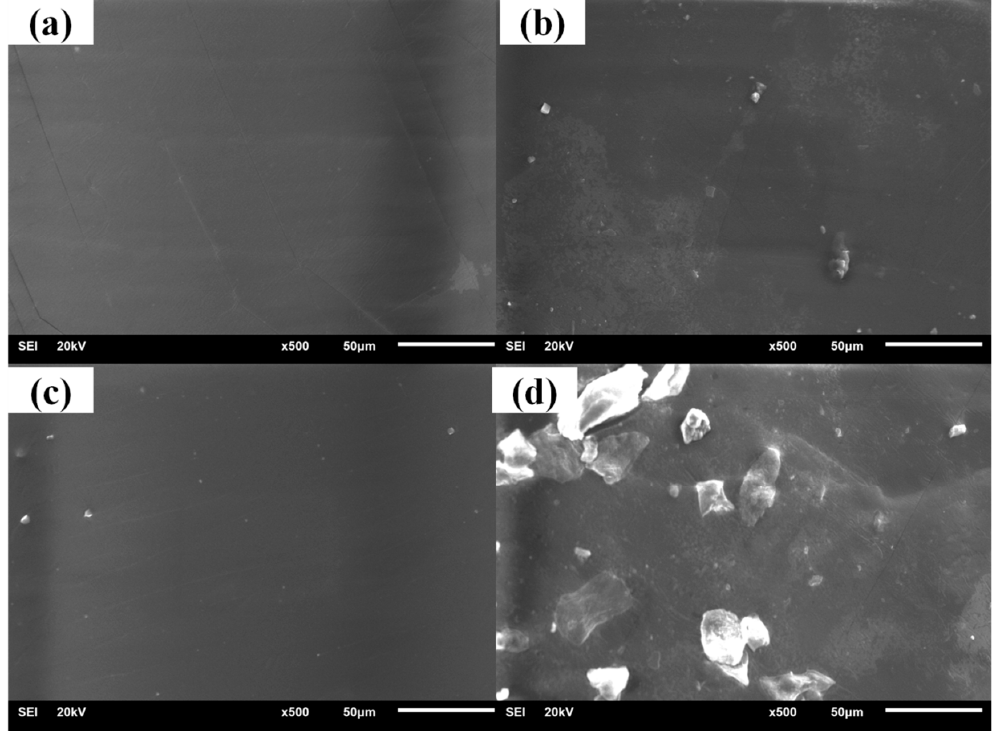
Figure 8. SEM patterns of XNBR/AO-60 before and after thermal aging: ( a ) XNBR/AO-60(20); ( b ) XNBR/AO-60(20) after aging; ( c ) XNBR/AO-60(60); ( d ) XNBR/AO-60(60) after aging.